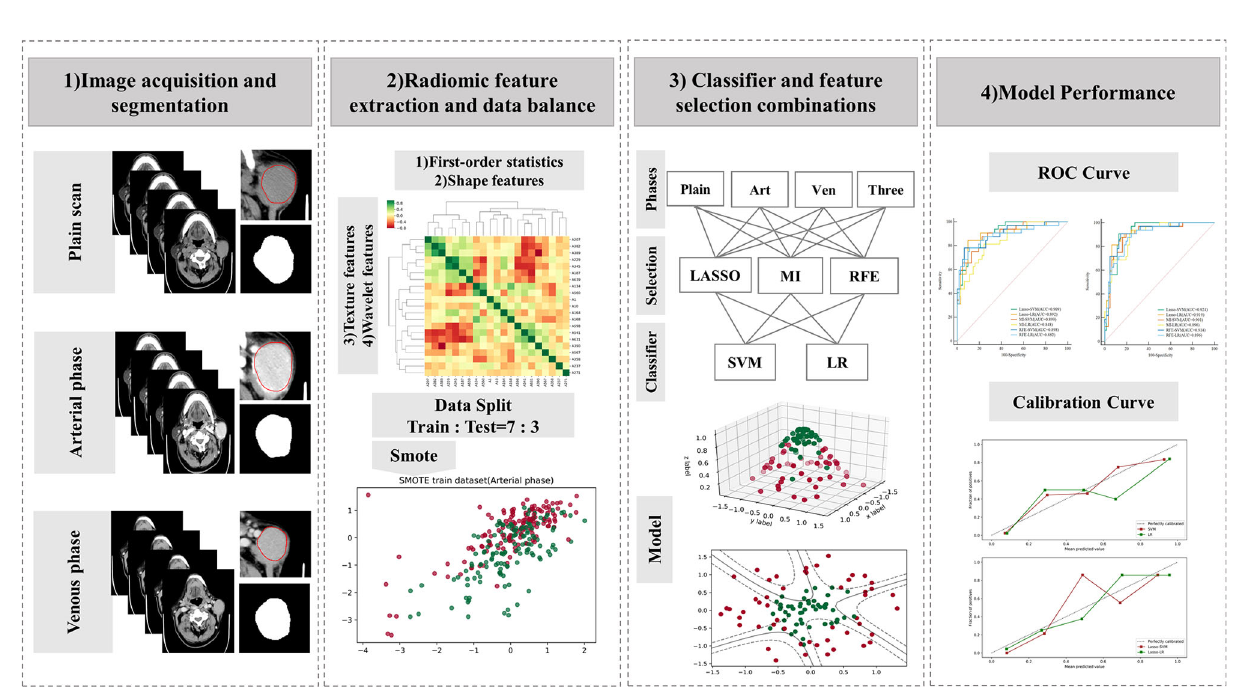
FIGURE 2 | Work fl ow of the radiomics analysis. LASSO, least absolute shrinkage and selection operator; MI, mutual information; RFE, recursive feature elimination; SVM, support vector machine; LR, logistic